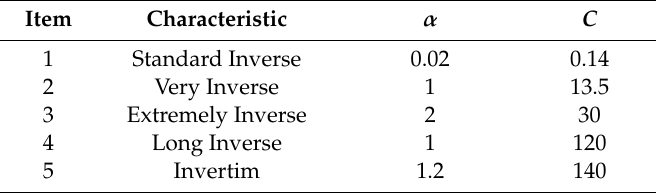
Table 1. Values of parameters α and C in accordance with References [4,16].